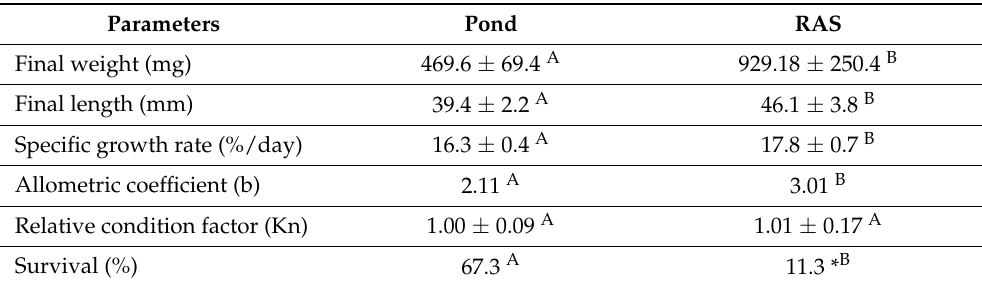
Table 1. Survival and morphometry of pond- and RAS-produced juveniles of pike-perch Sander lucioperca at the 42 DPH (mean ± S.D., for morphometric indices n = 30 and 40 fish in the case of RAS and Pond group, respectively). Initial weights of all fish (0 DPH) were approximately 0.5 mg. Results of t -test are provided as superscripts.